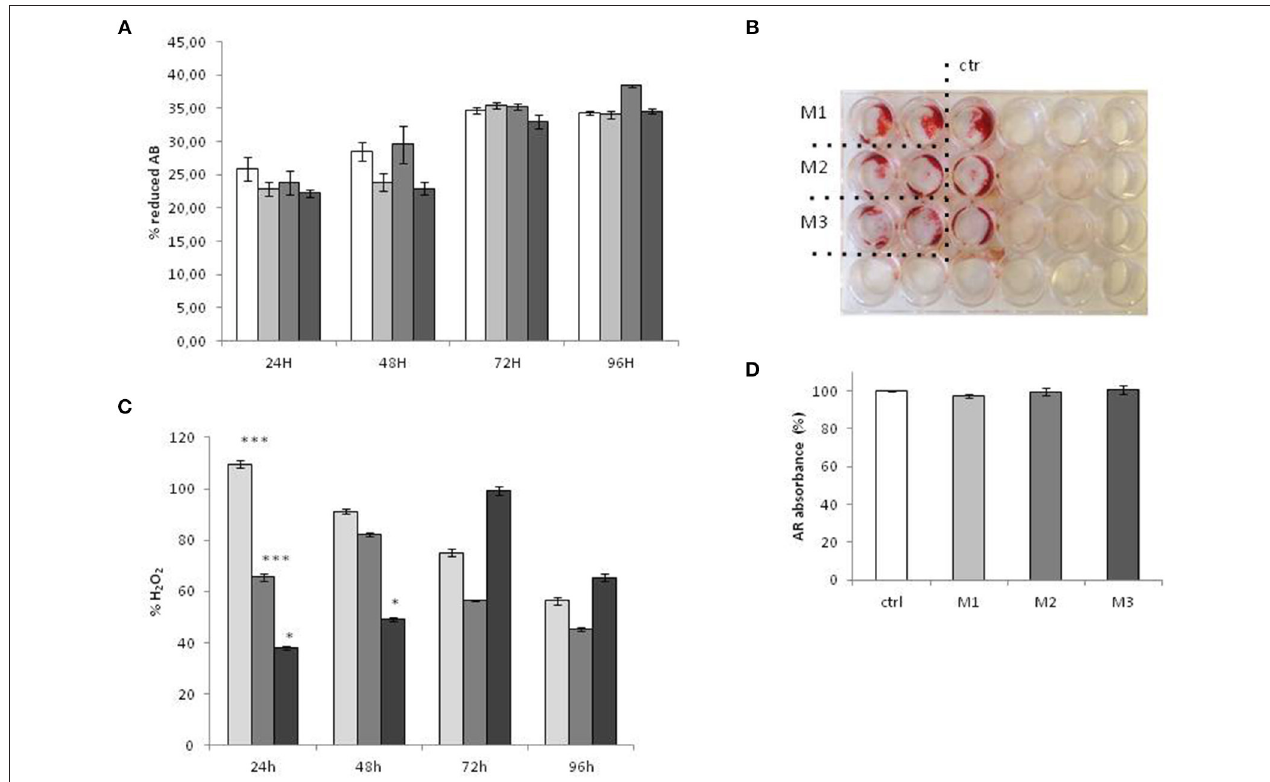
FIGURE 4 | Cell Vitality, mineralization, and ROS production after exposure to M1, M2, and M3 wear debris. (A) vitality and the growth rate of Sa0S2 cell evaluated by Alamar blue (A,B) . The vitality of the cells is expressed as percentage of reduced Alamar Blue (%AB), as indicated in Alamar Blue protocol. Mineralization Assay was evaluated by alizarin Red (AR) staining. The plates were observed under the Leica Microscope DML B2/11888111 equipped with Leica camera DFC450 at × 100 magnification (B) . For quantification of Alizarin red S, 500 µ l citrate solution containing 20% methanol and 10% acetic acid was added for 20min at RT, and the absorbance of supernatants was measured at 570nm using an Fluorescence Reader (GloMAx). The mineralization is expressed as percentage of Alzarin Red staining (% ARS) of treated cells vs. untreated control (D) . (C) ROS production was tested by OxiSelect TM In vitro ROS/RNS Assay kit. ROS production is expressed as percentage of H 2 O 2 production vs. untreated control. Materials M1, M2, M3 are described in the Methods section, as follows: Material M1a moderately cross-linked vitamin E-blended UHMWPE, EtO sterilized; Material M2 standard UHMWPE (without vitamin E and not cross-linked), EtO sterilized; Material M3 vitamin E-blended UHMWPE not cross-linked, EtO sterilized. Control (white bar) Material M1 (light gray bar), material M2 (medium gray bar), material M3 (dark gray bar). * p < 0.05; ** p < 0.01, statistically very significant; *** p <